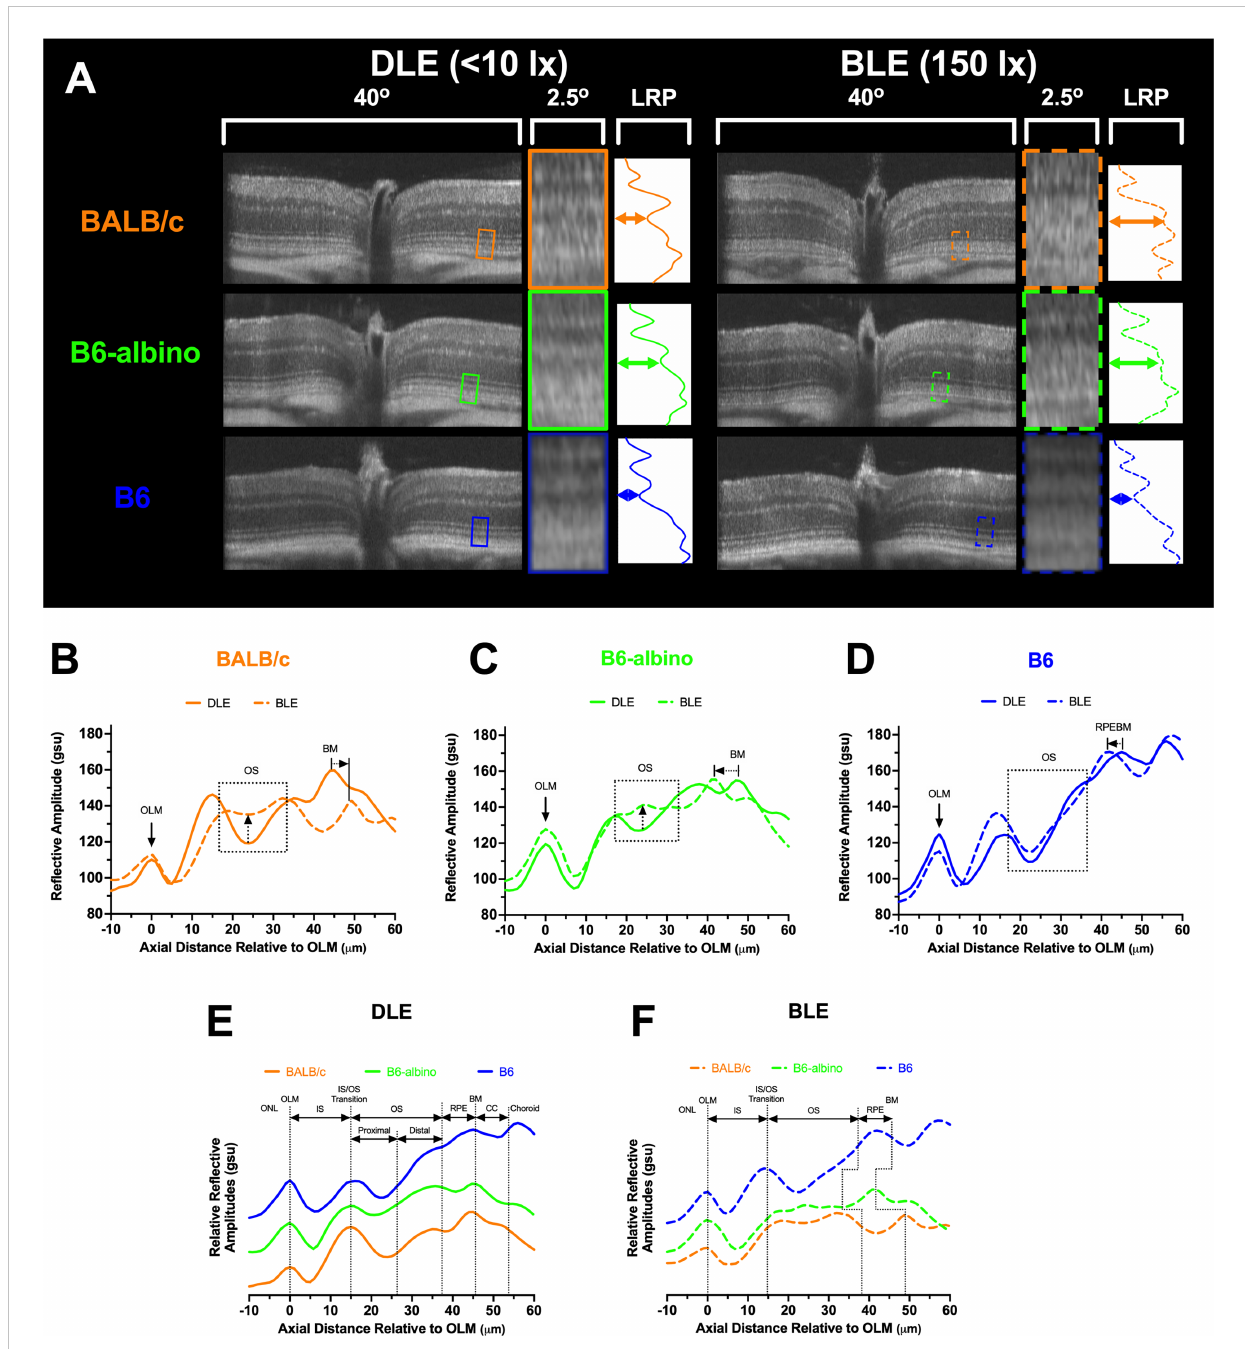
FIGURE 3 SD-OCT images and Longitudinal Re fl ectance Pro fi le (LRP) examples from DLE and BLE retinas of BALB/c, B6-albino, and B6 mice. (A) Co-registered and averaged 50° FOV (~1.5 mm width) B-scans from the horizontal meridian detailing the outer retina 2.4° region of interest (ROI). The ROI is a 40 pixel-wide window that is averaged to generate the Longitudinal Re fl ectance Pro fi le (LRP). The LRP displays the intensity vs. axial distance of the photoreceptor layer with a small portion of adjacent ONL and choroid. Location of normal or altered proximal outer segments under DLE or BLE conditions respectively, denoted by colored horizontal double arrows in the LRP examples. (B – D) LRPs are rotated CCW 90 degrees, aligned to the OLM and qualitatively compared to reveal differences between DLE and BLE conditions for BALB/c (B) , B6-albino (C) and B6 (D) strains. Changes in proximal OS signal re fl ectivity are accentuated with up-directional arrows for BALB/c and B6-albino mice housed in DLE vs BLE conditions. Changes in photoceptor layer thickness induced by BLE vs DLE can also be observed by looking at the relative locations of the RPEBM or BM for pigmented and albino mice, respectively. LRP comparisons between mouse strains for DLE (E) vs. BLE (F) conditions showing the proximal and distal author de fi ned designations for the photoreceptor outers segments relative to the widely accepted anatomical locations for a mouse retina SD-OCT B- scan. DLE housed mice show consistent morphology thicknesses between strains. Relative strain dependent changes in photoreceptor thickness can be observed in BLE housed mice (F) . Abbreviations: outer nuclear layer (ONL), outer limiting membrane (OLM), photoreceptor inner segment (IS), photoreceptor outer segments (OS), retinal pigment epithelium (RPE), Bruch ’ s membrane (BM), retinal pigment epithelium-Bruch ’ s membrane complex (RPEBM), and choriocapillaris